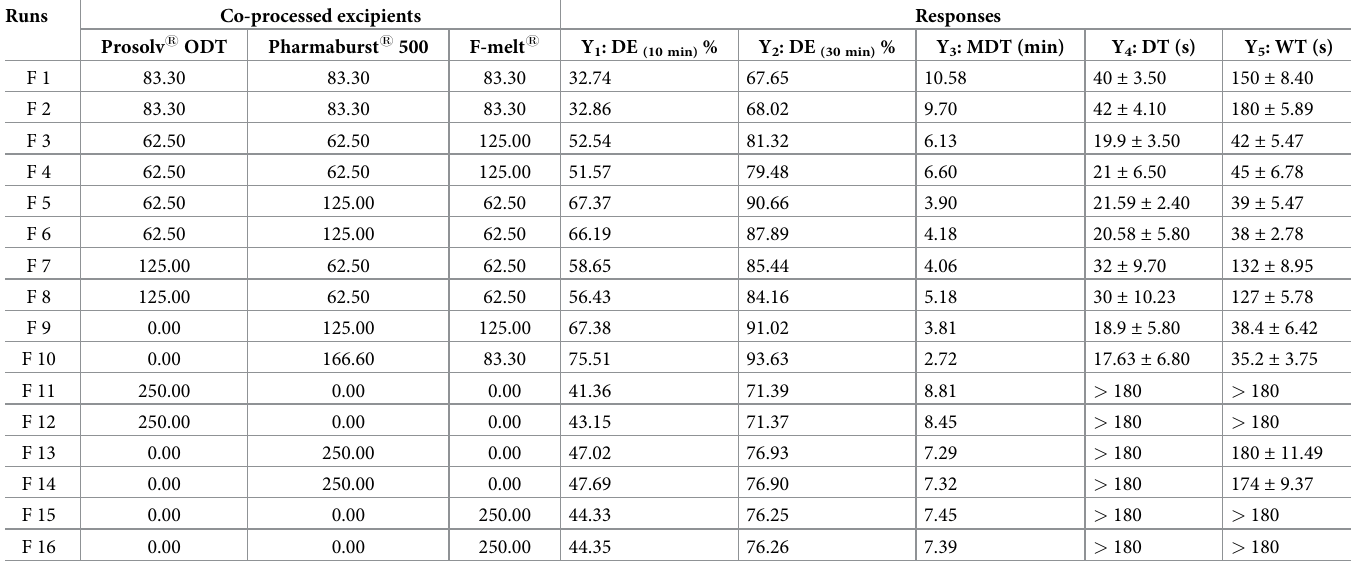
Table 2. Experimental runs, formulation variables and measured responses of the I-Optimal mixture experimental design a,b . Runs Co-processed